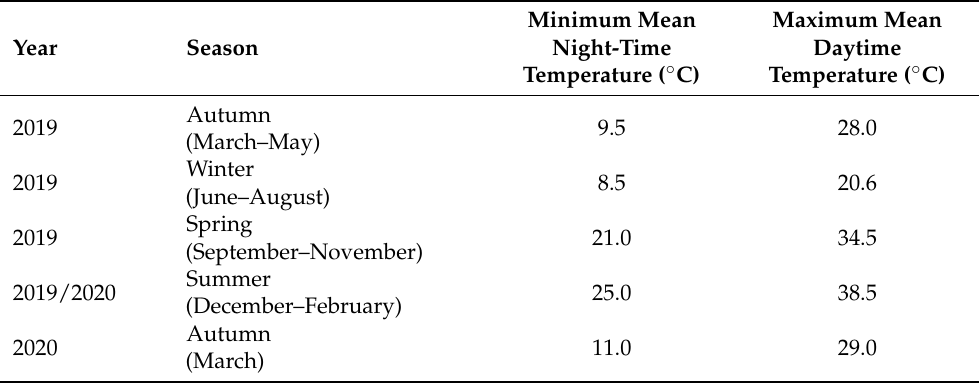
Table 5. Temperatures inside the glasshouse housing the rooting chamber during the study